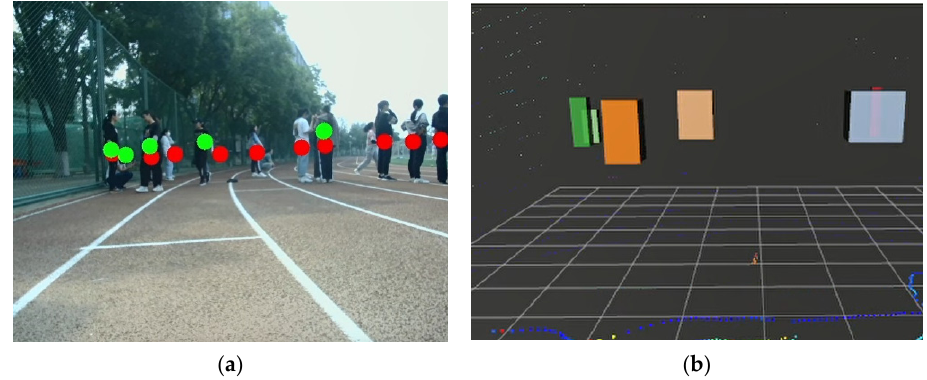
( b ) Figure 13. Fitting curves of false positive rate under different scenarios. ( a ) Outdoor environment. ( b ) Academic building. The lower the FP rate of pedestrian targets, the better the detection effect of the fusion algorithm. With the increase in the pedestrian occlusion rate, the FP rate of pedestrian targets will gradually increase. The FP rate of the fusion algorithm is lower than 5% when the pedestrian occlusion rate is below 20% in the academic building and outdoor environ- ment, as shown in Figure 13. Therefore, the fusion algorithm has higher accuracy and stronger robustness compared to the single-sensor detection algorithm. The accuracy of the pedestrian detection method based on the fusion algorithm satisfies the requirements of the crowd density estimation algorithm. Moreover, we evaluate the effectiveness of crowd density estimation in experimental scenarios through a three-part experiment, which includes: (1) crowd clustering threshold selection and crowd detection implementation; (2) crowd density distribution verification;